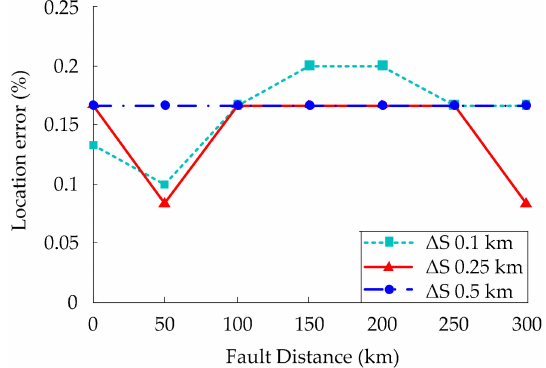
Figure 12. Location error with different calculating steps.